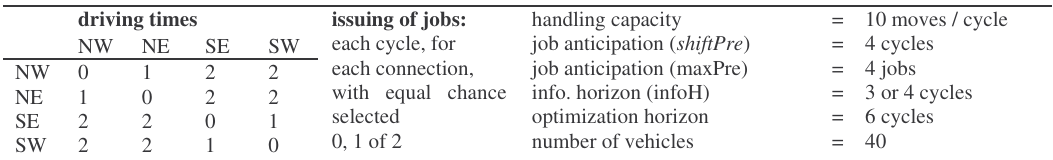
Table 7. Example of criss-cross transport of the model of figure 2 (without external platform)